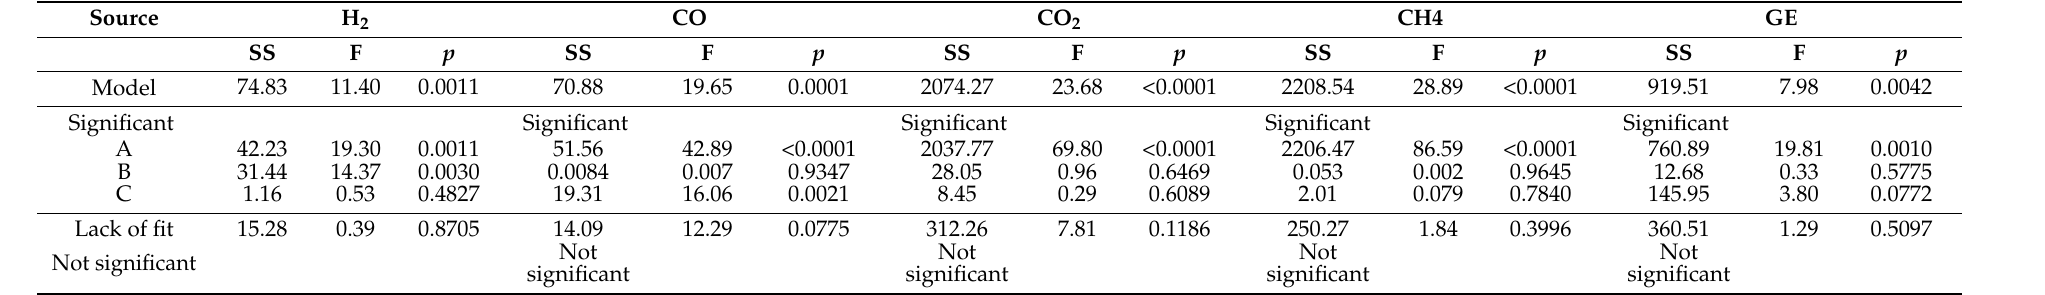
Table 5. ANOVA results for the model using the Box–Behnken